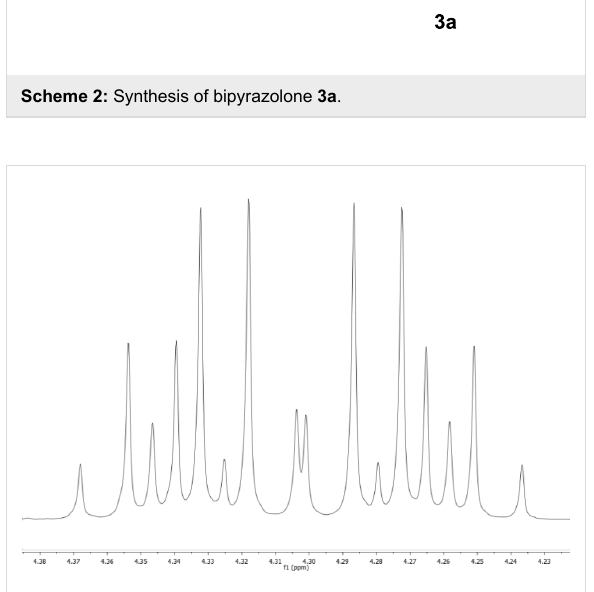
Figure 1: Signal of the OCH 2 ester protons of reaction product 3a (500 MHz, CDCl 3